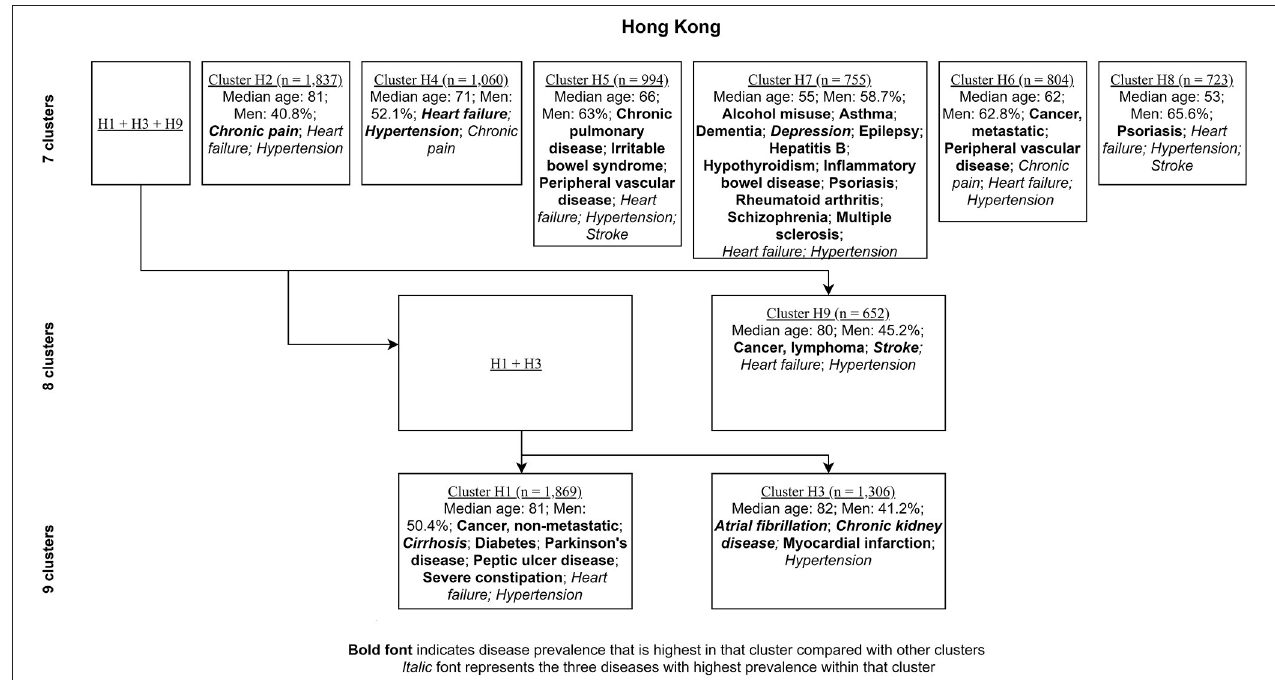
FIGURE 4 | Clustering process (from seven to nine clusters) of Hong Kong inpatients labeled with characterizing diseases.